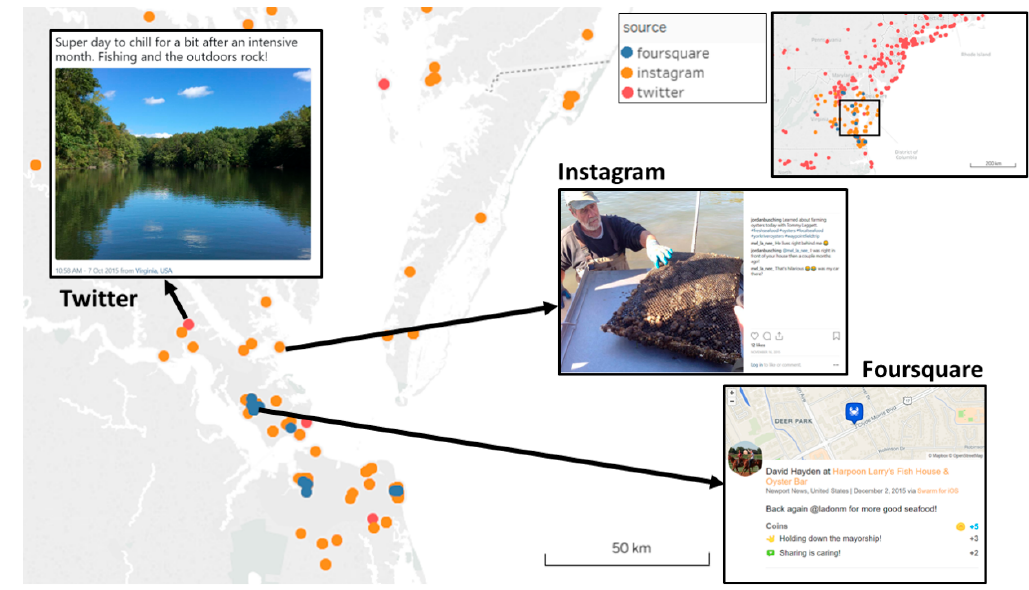
Figure 3. Example of information on people’s use of natural resources from social media data based on key word searches fish and oyster from Twitter, Instagram and Foursquare.